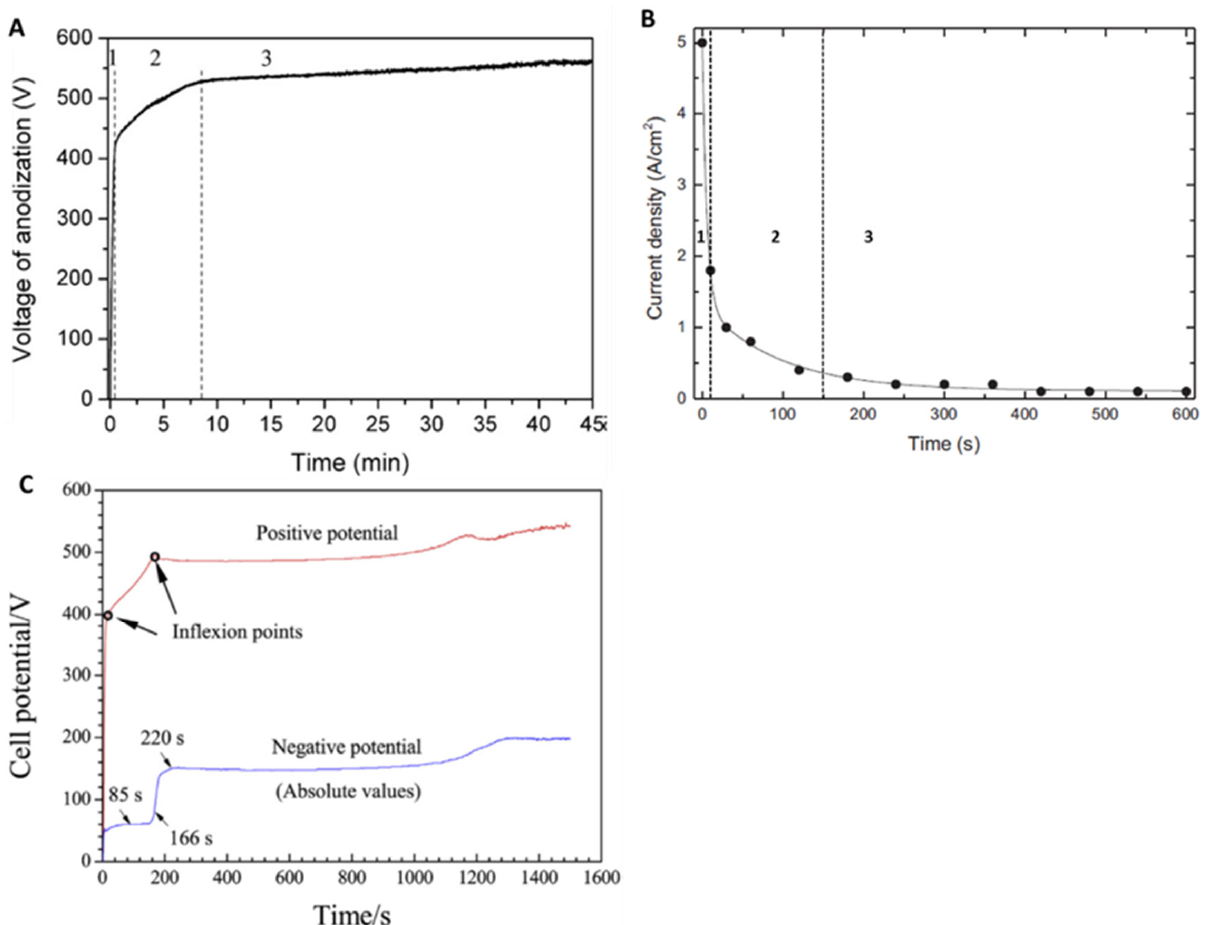
Figure 3. ( A ) Voltage–time curve. Adapted with permission from Ref. [46]. Copyright 2011 Elsevier. ( B ) Current–density curve. Reprinted with permission from Ref. [55]. Copyright 2019 Elsevier. ( C ) Cell-potential–time responses recorded during MAO treatment. Adapted with permission from Ref.